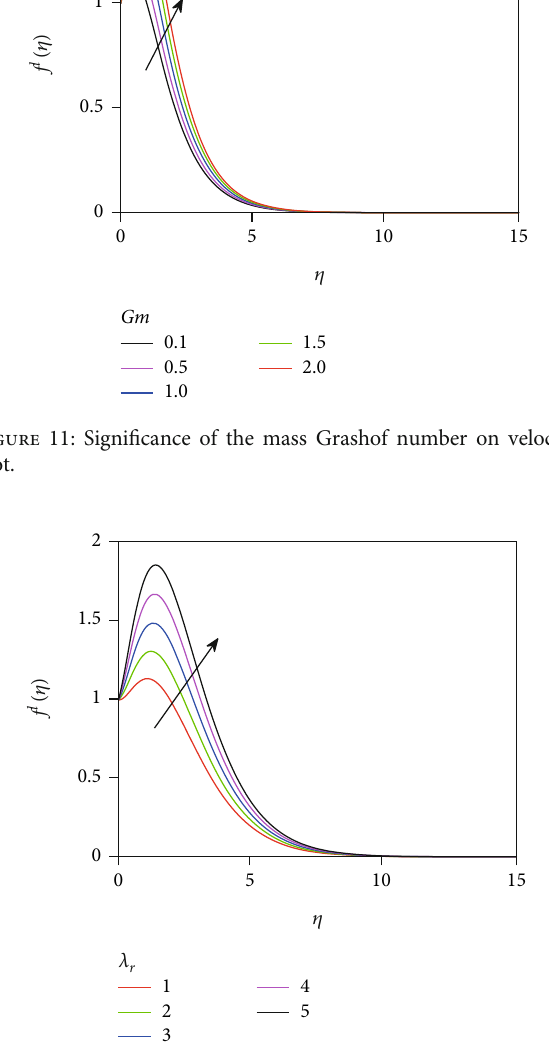
Figure 12: Signi fi cance of the nonlinear convective temperature parameter on velocity